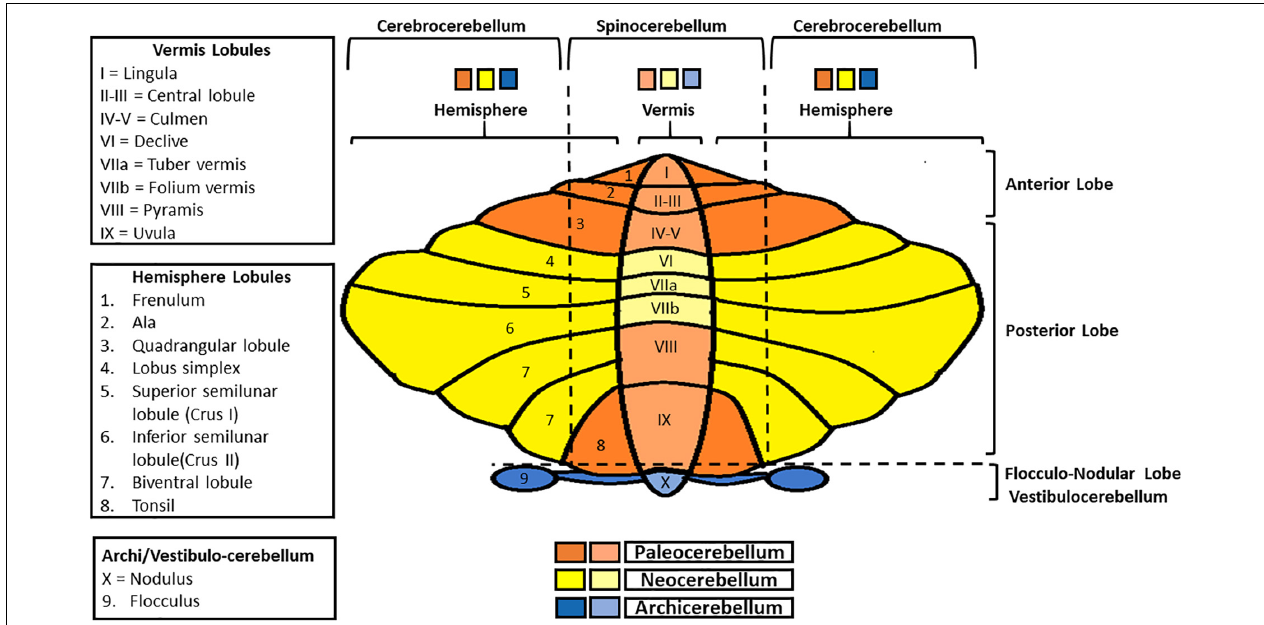
FIGURE 1 | Schematic representation of cerebellar gross anatomy. Anterior-posteriorly, the cerebellum presents three lobes (anterior, posterior, and flocculo-nodular), each one subdivided in lobules. Medio-laterally, it is composed of a central part (the vermis), and two lateral ones (cerebellar hemispheres). Vermis and paravermial zones form the spinocerebellum, so-called since it communicates with the spinal cord; the most lateral zones of the hemispheres constitute the cerebrocerebellum, in connection with the cerebral cortex. Finally, in regard to phylogenesis, the cerebellum can be divided into three parts: the archicerebellum (the most ancient one, corresponding to the vestibulocerebellum), paleocerebellum and